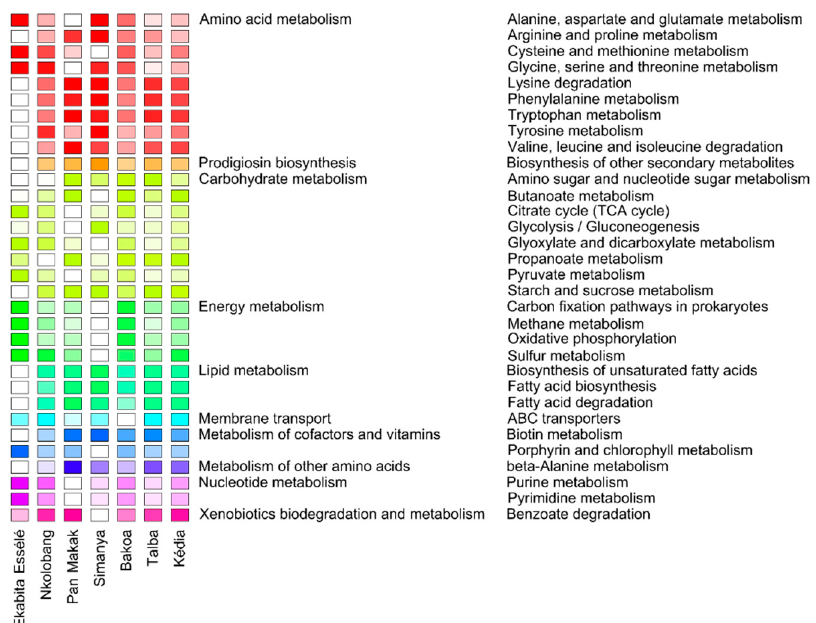
Figure 7. Predicted functional profiles of bacterial endophytes in T. cacao leaves. The color code refers to the relative abundance of each pathway, with high predicted abundances (dark-colored) and low predicted abundances (light-colored). The relative abundances of pathways were calculated for each site. Only pathways with an average abundance ≥ 1% in the entire data set are shown.